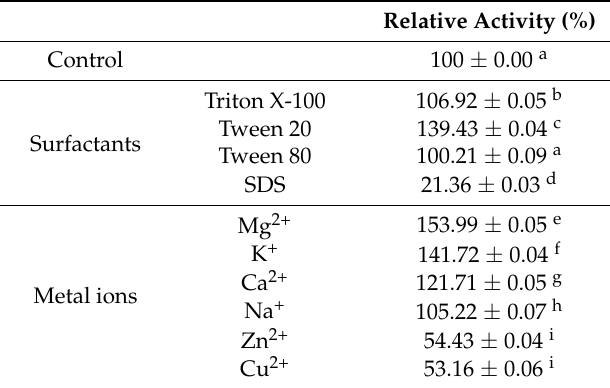
Table 4. Effects of different additives on lipase